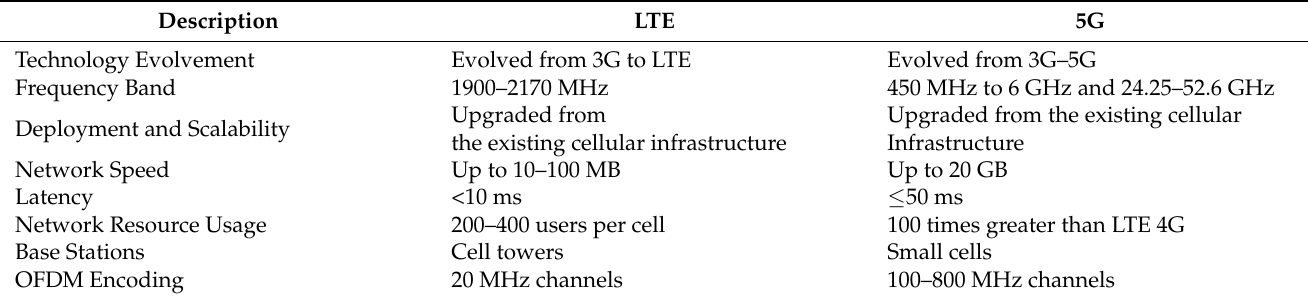
Table 1. Technological comparison between LTE and